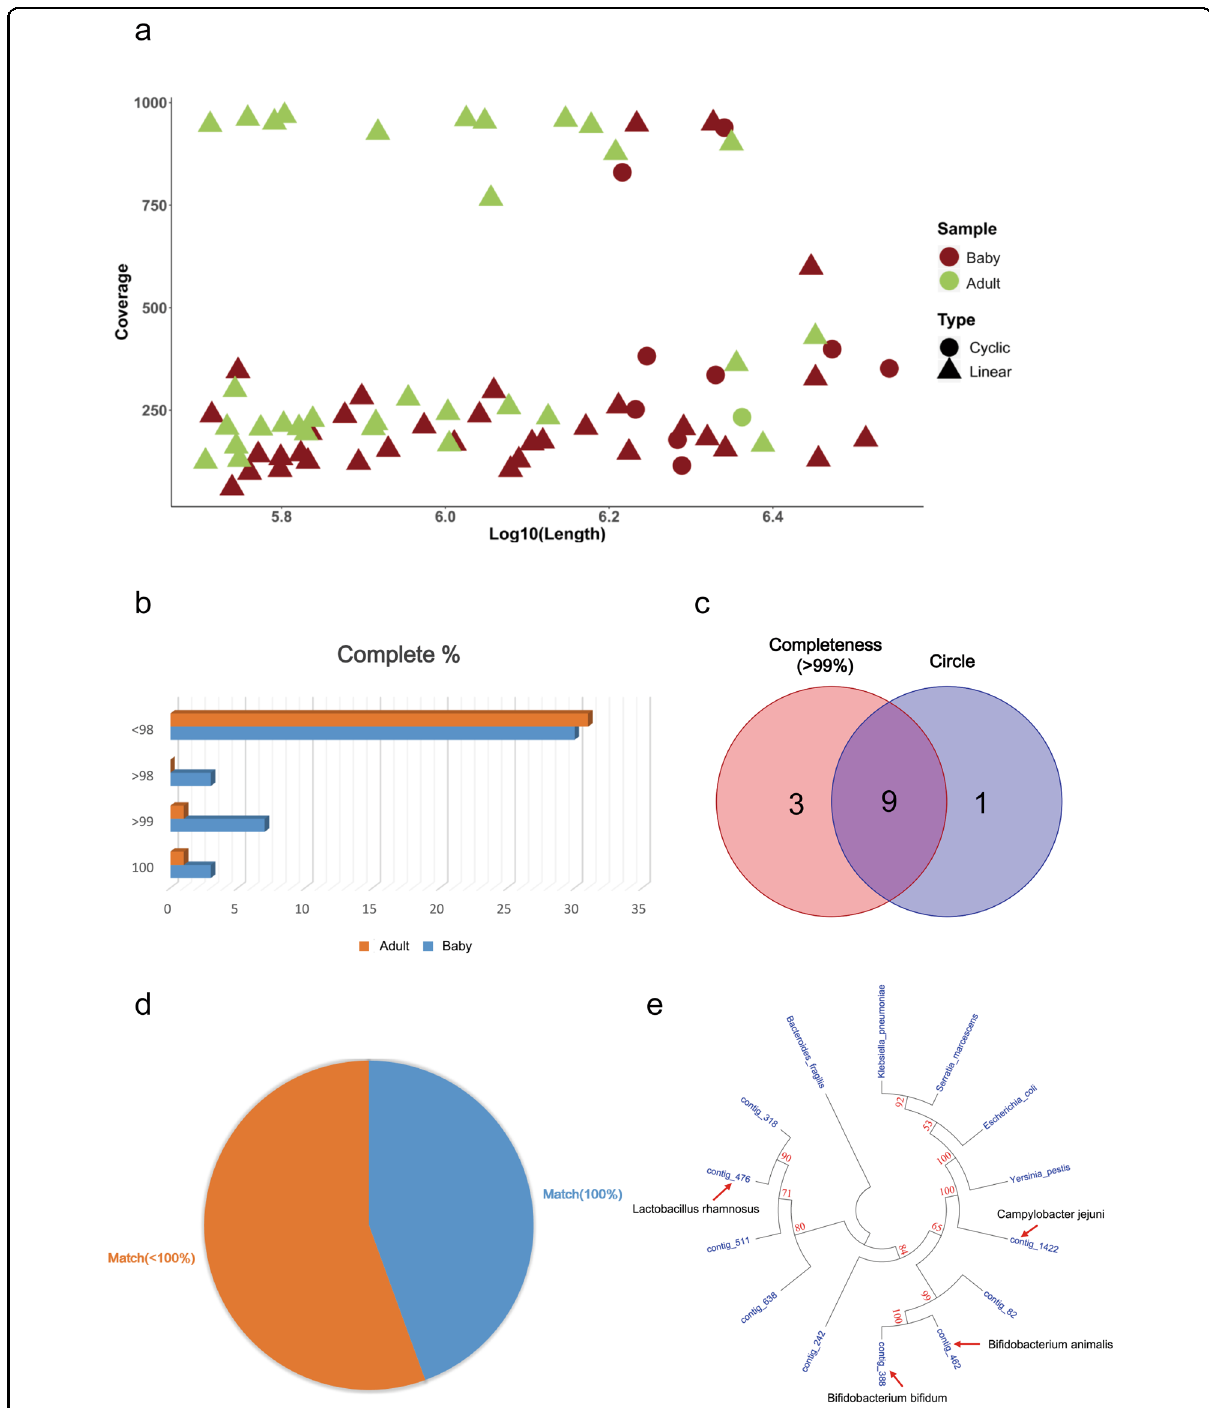
Fig. 2 The different aspects of the contigs (longer than 0.5 Mb) in the two samples. a The length and coverage of the contigs in the two samples ( longer than 0.5 Mb). b Complete analysis of the contigs in the two samples. c Wenn diagram shows the number of contigs (Complete ≥ 99% or circle). d Pie diagram shows the number of the nine genomes whether they match public genomes. e Phylogenetic tree of the nine assembled genomes, each arrow shows the completely matched